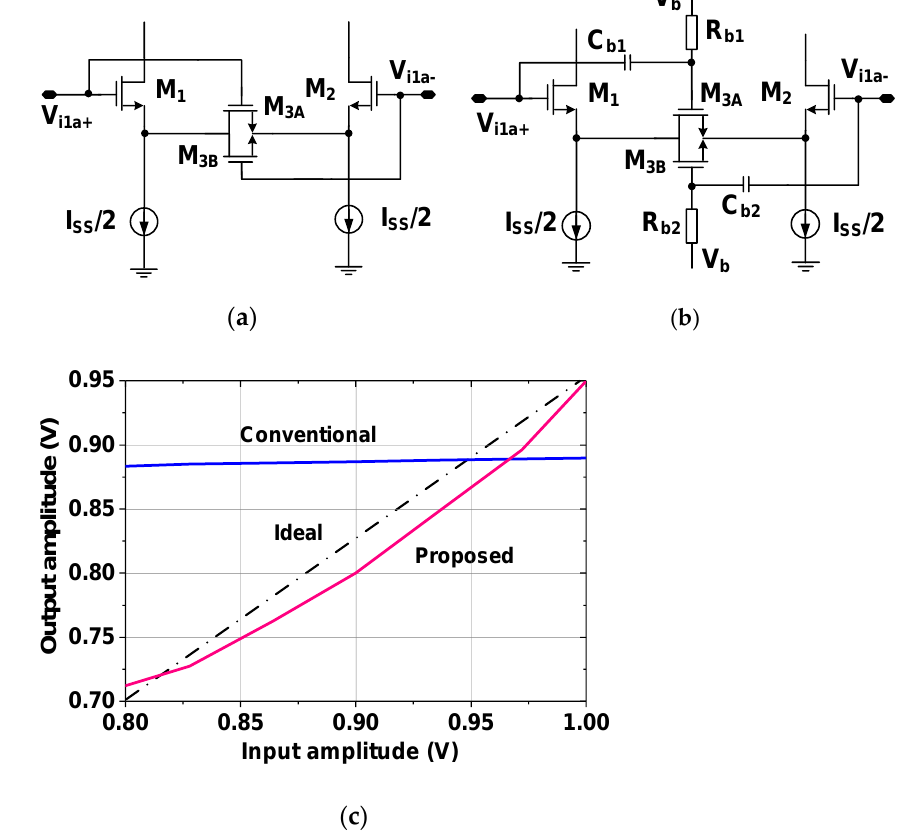
Figure 4. Source degeneration method using ( a ) conventional and ( b ) proposed approach. ( c ) Com- parison of the transfer